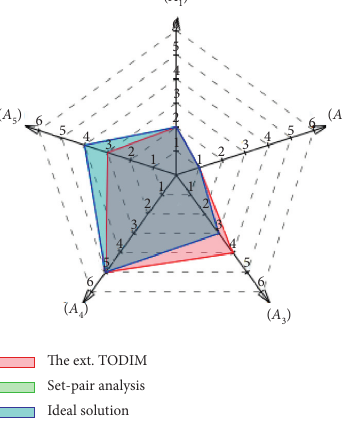
Figure 1: The comparison results.